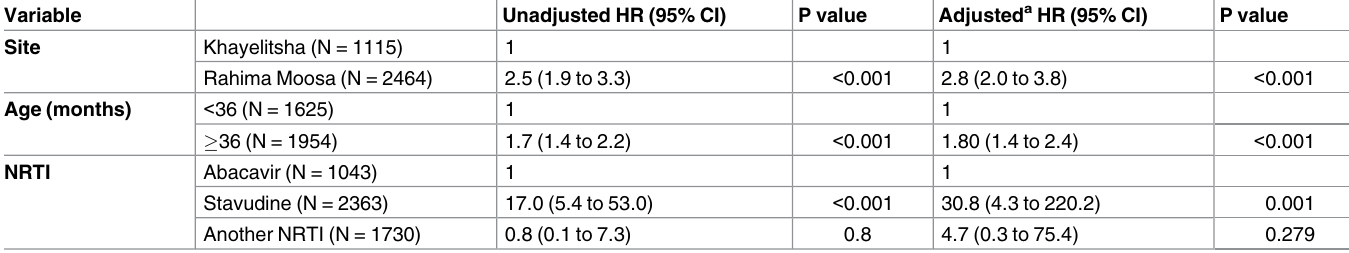
Table 2. Predictors of discontinuations due to toxicity using cox-proportional hazards regression among children followed up until 5 years (n = 3579).